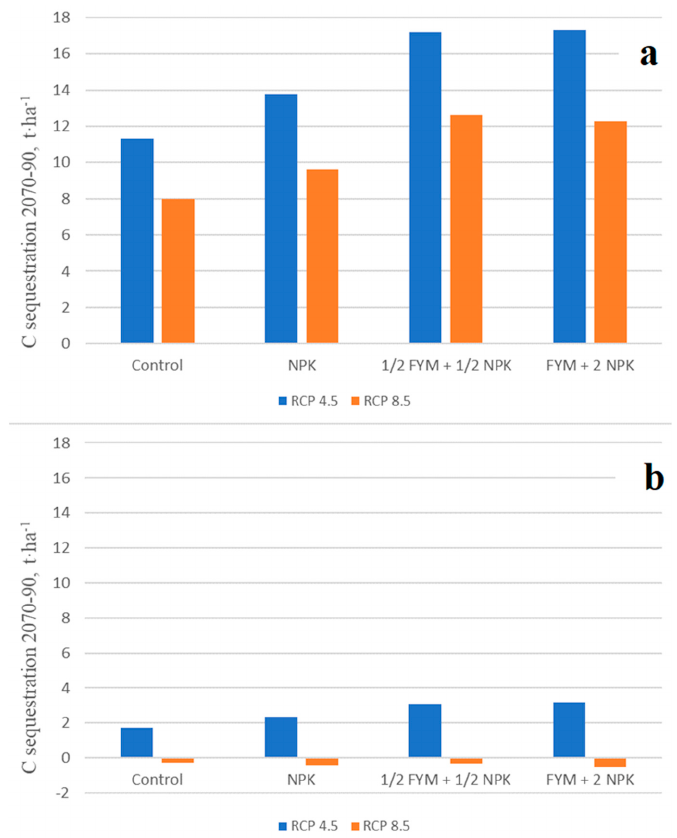
Figure 6. Simulated soil carbon sequestration under future climatic scenarios RCP4.5 and RCP8.5 between 2018 and 2070 ( a ) and between 2070 and 2090 ( b ) for the different treatments.